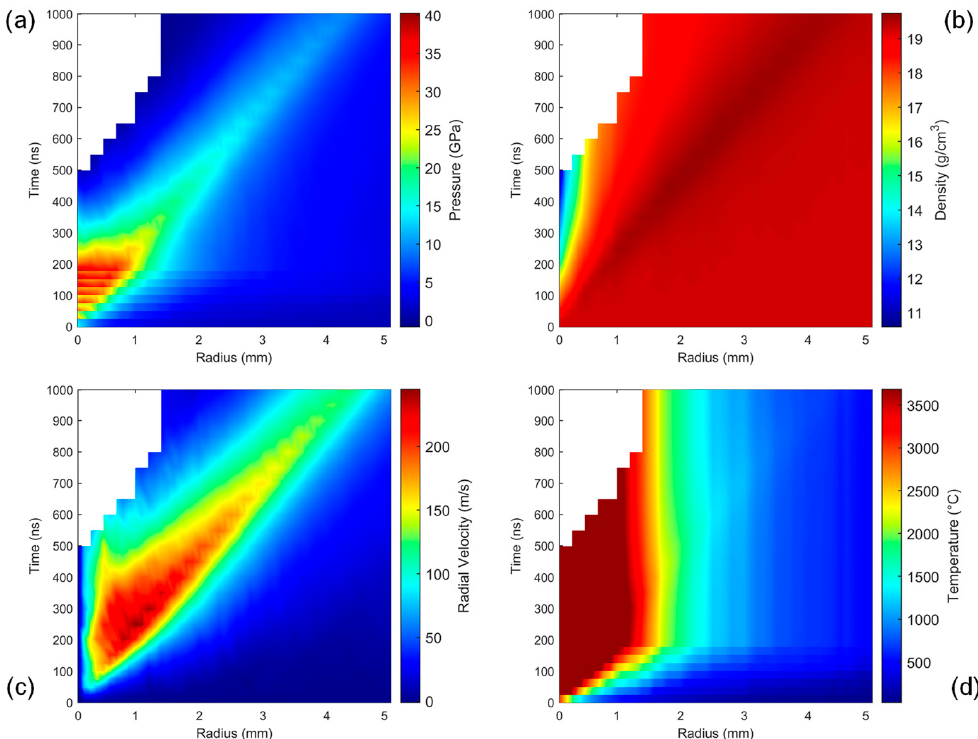
Figure 10. Pressure ( a ), density ( b ), particle velocity in radial direction ( c ), and temperature ( d ) distributions by varying the radius at 50 cm from the impacted base (L 50 of Figure 5).